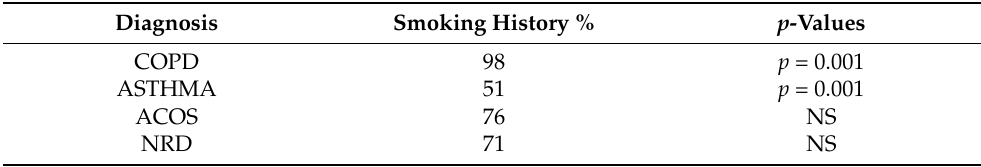
Table 2. Prevalence of smoking history for each